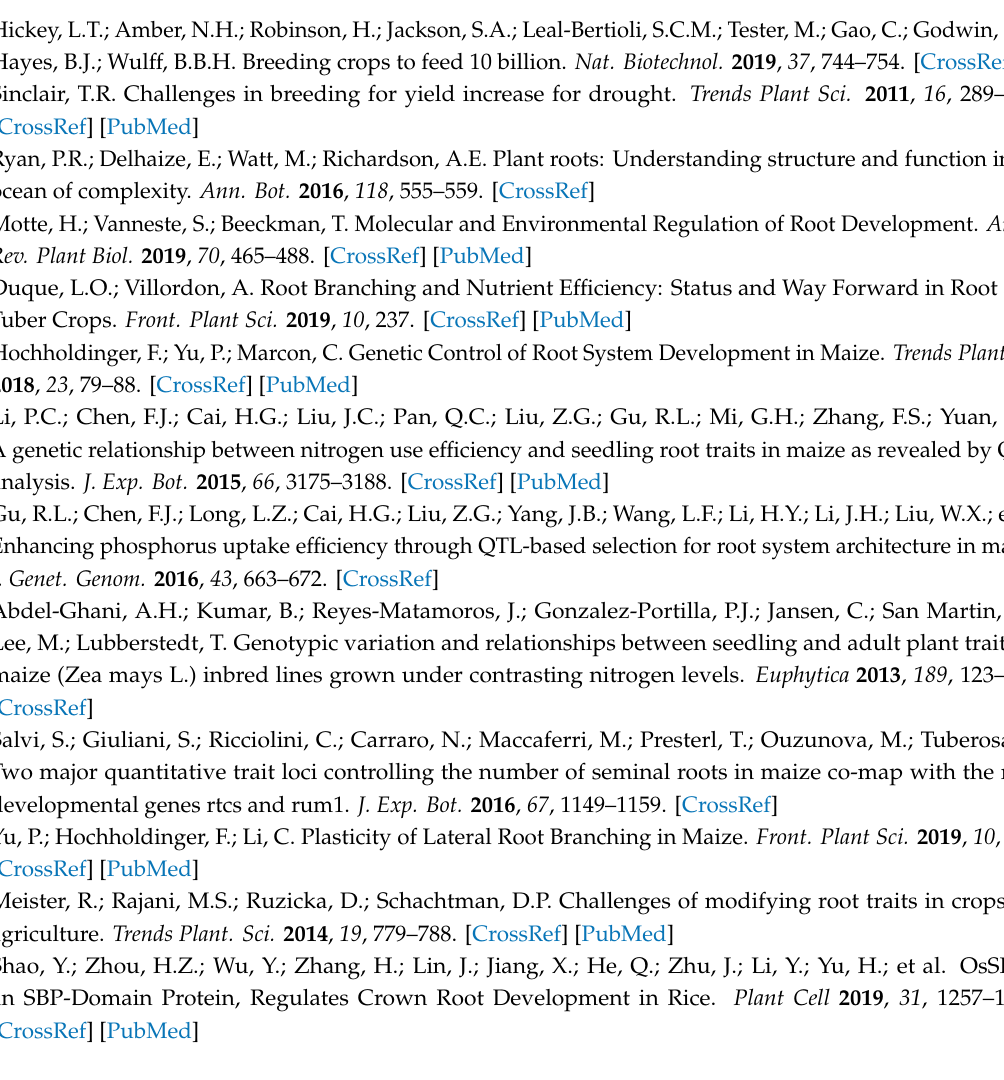
Figure S1: Pearson correlation coe ffi cients for root and shoot traits, Figure S2: Principal components analysis of traits in 297 inbred maize lines, Figure S3: Linkage disequilibrium decay across the whole genome in 297 inbred maize lines, Table S1: Linkage disequilibrium decay across the whole genome in 297 inbred maize lines, Dataset 1: Significant and suggestive SNPs detected by GWAS, Dataset 2: Identification of candidate genes in QTL regions detected by GWAS, Dataset 3: Gene di ff erential expression between long- and short-root lines by RNA-seq analysis, Dataset 4: SNP and its annotation, Dataset 5: Statistics of the SNP in candidate